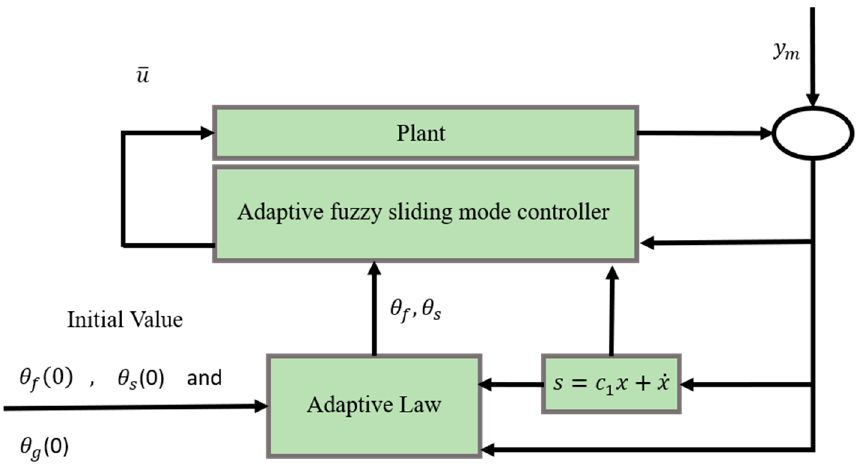
Figure 17. Block diagram of the control system proposed by Li et al. [178].